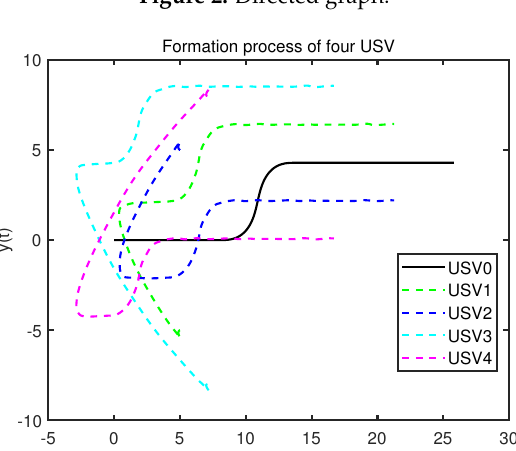
Figure 2. Directed graph.